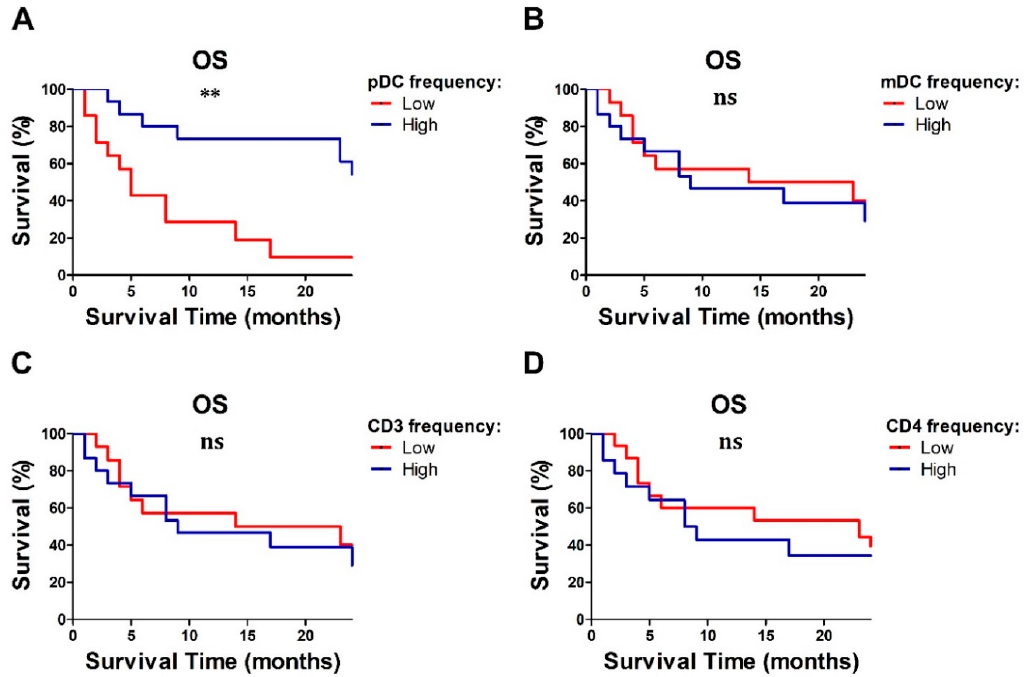
Figure 6. Survival analysis of MM patients according to immune cell subsets. Overall survival analysis (OS) according to the frequency of pDCs ( A ), mDCs ( B ), CD3 + ( C ), and CD4 + T lymphocytes ( D ) ( N = 29) are reported. Survival analysis was performed using the Kaplan–Meier method and the statistical significance was calculated by the log-rank test. ** p < 0.01; ns = not statistically significant p -value. Table 5. Univariate and multivariate Cox regression models for OS in MM patients at baseline (T0; N = 29).